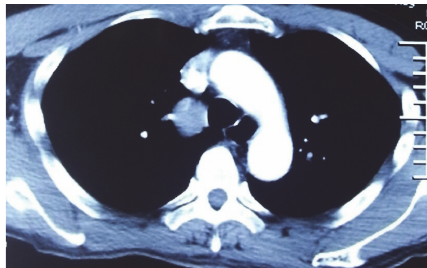
Figure 1: Contrast computed tomography confirmed a slowly enhancing mass with a smooth margin adjacent to the right side of the trachea in the pathway of the azygos arch.